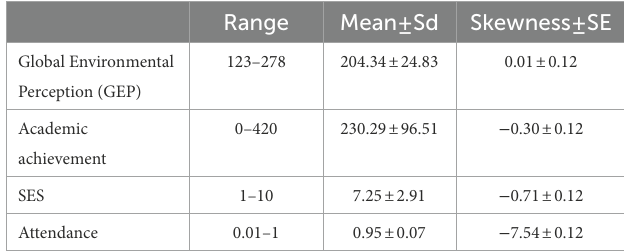
TABLE 1 Descriptive statistics for hypothesis one, study